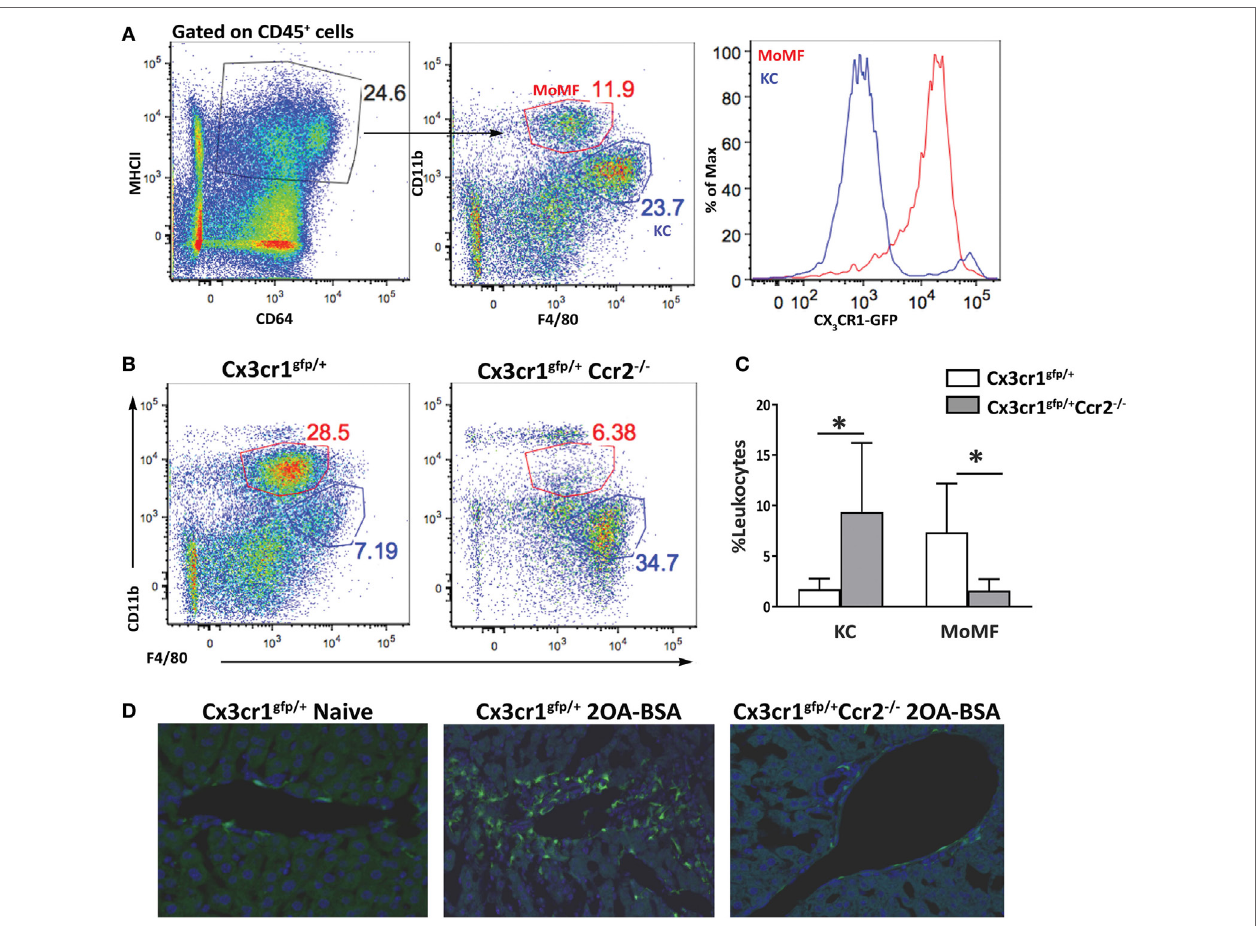
FigUre 1 | Monocyte-derived cells accumulate around bile ducts in the murine 2-octynoic acid conjugated to bovine serum albumin (2OA-BSA) autoimmune cholangitis model. (a) Flow cytometry analysis of non-parenchymal liver cells of Cx3cr1 gfp/ + mice at steady state. (B) Flow cytometry analysis of non-parenchymal liver cells of Cx3cr1 gfp/ + and Cx3cr1 gfp/ + Ccr2 − / − mice, 8 weeks following immunization with 2OA-BSA. (c) Graphical summary of flow cytometry analysis of non-parenchymal liver cells of indicated mice, 8 weeks post immunization with 2OA-BSA. (D) Representative fluorescent microscopy images of livers from Cx3cr1 gfp/ + and Cx3cr1 gfp/ + Ccr2 − / − mice 8 weeks post immunization with 2OA-BSA and naïve Cx3cr1 gfp/ + mice (Green—CX3CR1-GFP, Blue—DAPI). Data are presented as mean ± SEM ( n ≥ 10). * p < 0.05 (unpaired Student’s t